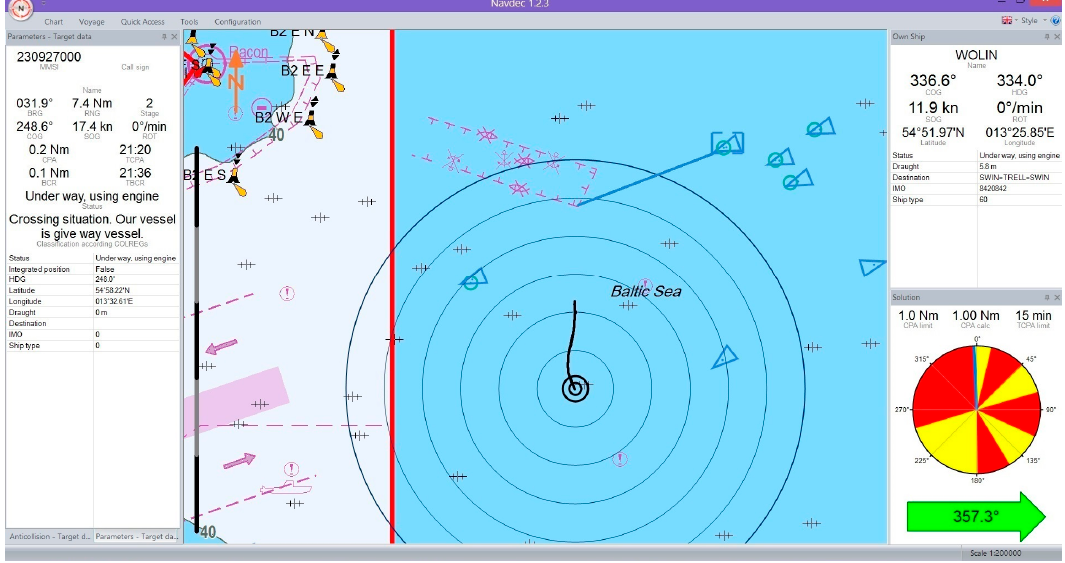
Figure 4. The ship trajectory prediction in the NAVDEC—example one.